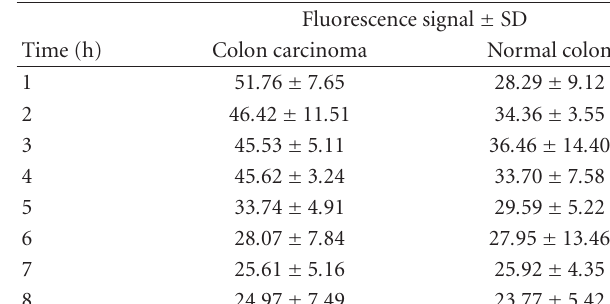
Figure 3: Typical fluorescence emission spectra from colon carci- noma and normal colon. Table 1: The relative concentration of Photogem in colon car- cinoma and normal colon according to fluorescence intensity at 622 nm as a function of time after PS administration is presented. Data is shown as the respective values and standard deviation